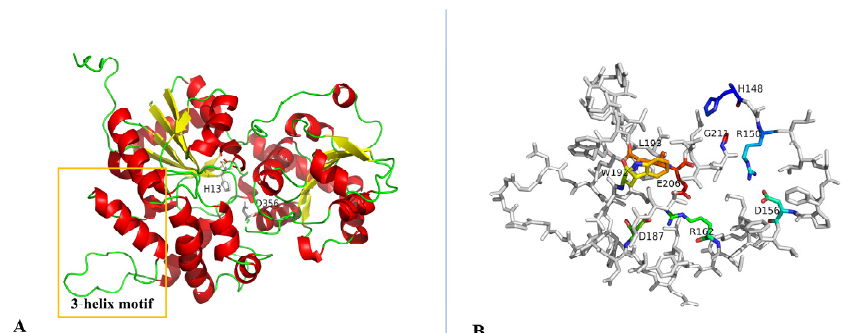
Figure 6. Predicted structure module of AknS. ( A ) AknS monomer prediction carried by AlphaFold Monomer v2.0; ( B ) The three-helix motif in AknS with labels of highly conserved residues.